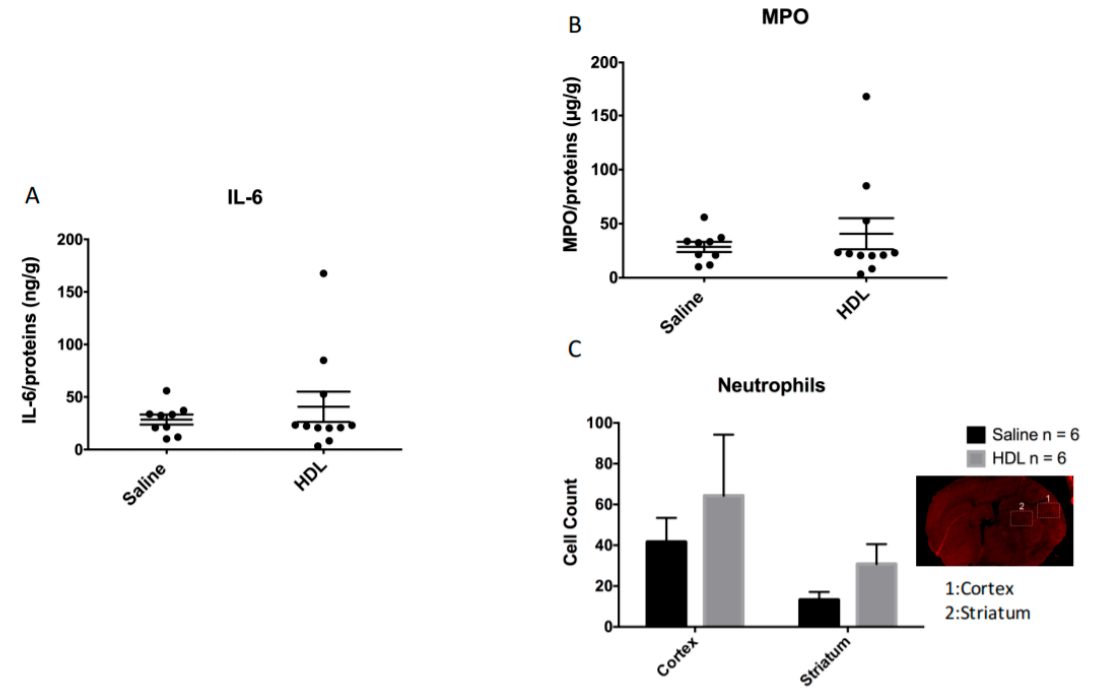
Figure 4. Brain inflammation in acute HG condition. ( A ): Interleukin-6 (IL-6) quantification by ELISA on the infarcted brain region. Saline: n = 9, HDL: n = 11. ( B ): Myeloperoxidase (MPO) quantification by ELISA on the infarcted brain region. Saline: n = 9, HDL: n = 11. ( C ): The number of neutrophil positive cells per selected field was evaluated in two areas of the ischemic brain: the cortex (1) and the striatum (2). Saline: n = 6, HDL: n = 6.